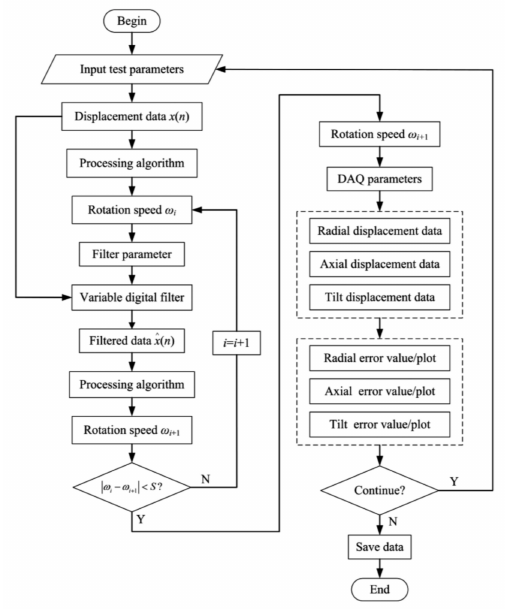
Figure 58. The structured flowchart of the measuring module